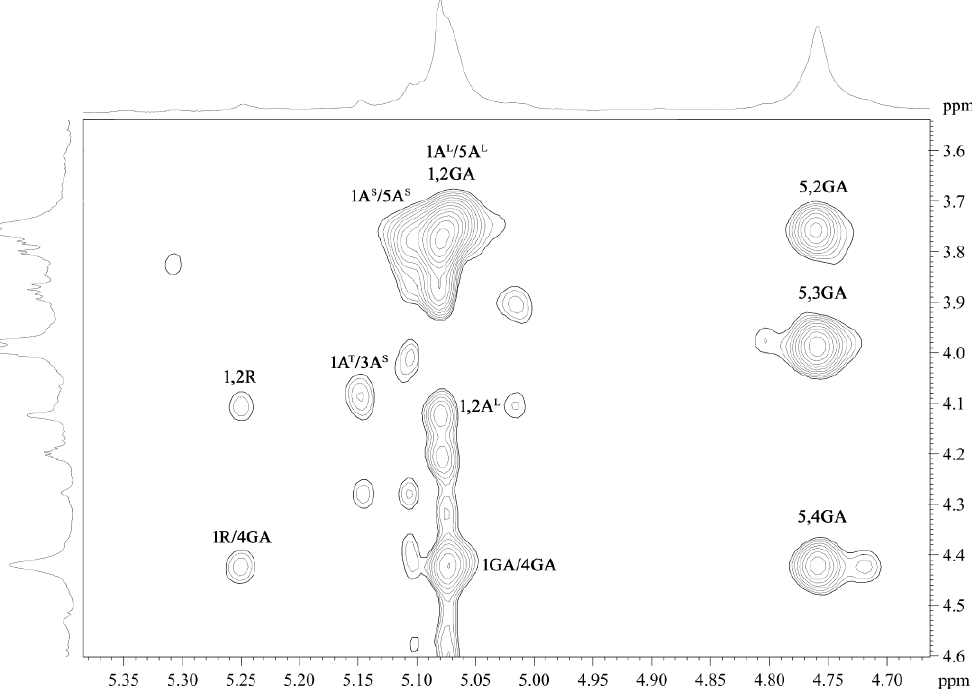
Figure 7. Part of 1 H, 13 C HMBC spectrum of the SO1-1 . The corresponding parts of the 1 H and 13 C NMR spectra are shown along the X and Y axes, respectively. Arabic numerals before slash refer to the protons, and those after slash refer to carbon atoms in the corresponding residues. Three intense signals at δ H 5.16, 5.12 and 5.09 ppm belonging to terminal nonreduc- tion arabinose residues (label A T ), 3,5-substituted arabinose residues (label A S ) and 1,5- linked arabinose residues (label A L ), respectively, were found in the anomeric region of 1 H NMR spectra of SO1-1 and SO1-2 (Figure S1). In the anomeric region, the 1 H NMR spectrum of SO1-3 signals of 3,5-Ara and 1,5-Ara overlaps the intense signal belonging to the 1,4-linked D-galacturonic acid residues (label GA ) at δ H 5.08 ppm. The resonance of C-6 at δ C 176.0 ppm indicated the predominance of non-methyl- esterified α -1,4-linked D-GalA residues in the structure of polysaccharides SO1-3 (Figure 2c), but the signal of low intensity at δ H/C 3.86/54.4 ppm confirmed that some GalA residues were methyl esterified. The following inter-residue correlations H-1(glycosylating GA )/H-4(glycosylated GA ) at δ H/H 5.08/4.44 ppm in the ROESY spectrum of SO1-3 (Figure 6) and H-4(glycosyl- ated GA )/C-1(glycosylating GA ) at δ H/C 4.44/100.3 ppm in the HMBC spectrum of SO1-3 (Figure S2) indicated on the galacturonan (HG) in the studied polysaccharides. The c orrelation peak at δ Н/С 2.09/21.56 ppm in the HSQC spectrum of SO1-3 (Figure 5) confirmed the O -acetylated residues in the structure of polysaccharides from S. passer- ina . No clear evidence was obtained for the attachment of the O -acetyl group to specific residues, since the intensity of their signals was low. Rha and GalA residues may be acetyl esterified [30]. The signals of O-acetyl groups are present only in the spectrum of sample SO1-3, which included polysaccharides with a high content of GalA, which may indirectly indicate the O-acetylation of GalA residues. The resonance of C-6 at δ C 176.0 ppm indicated the predominance of non-methyl- esterified α -1,4-linked D-GalA residues in the structure of polysaccharides (Figure 2). The sequence of Ara residues in the repeating units was determined using the H/C correlations in the HMBC spectra and the H/H correlations in the ROESY spectra. The inter-residue correlation peaks — H-1(glycosylating A S )/C-5(glycosylated A S ) and H-1(glycosylating A L )/C-5(glycosylated A L ) in HMBC spectra (Figures 7 and S2) and H-